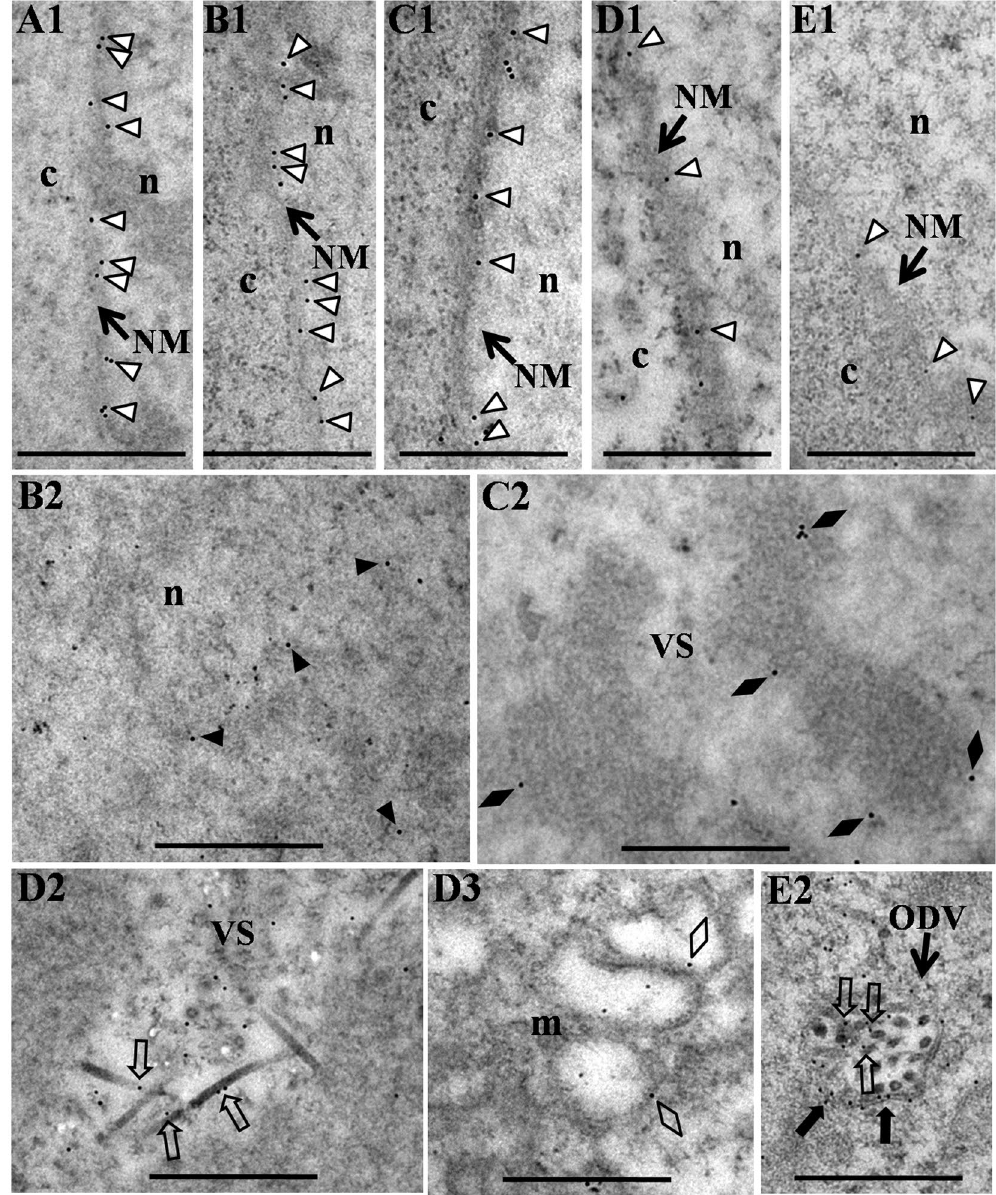
Figure 4. Immunoelectron micrographs showing the distribution of GFP-lamin B in mock- or vAc76:FLAG- infected Sf9-L cells. At the designated time points p.i., the cells were fixed, dehydrated, embedded in LR White resin, and processed for immunogold labeling with a mouse monoclonal anti-GFP antibody. ( A1 ) A mock- infected cell. ( B1–E2 ) vAc76:FLAG-infected cells at 12 h p.i. ( B1, B2 ), 24 h p.i. ( C1, C2 ), 36 h p.i. ( D1–D3 ) and 48 h p.i. ( E1, E2 ). c, cytoplasm; n, nucleus; NM, nuclear membrane; m, microvesicle; VS, virogenic stroma; ODV, occlusion-derived virion; open triangles, labeling of the nuclear lamina; black triangles, labeling of the VS; black diamonds, labeling of the edges of the electron-dense stromal mattes of the VS; open arrows, labeling of the nucleocapsids; open diamonds, labeling of intranuclear microvesicles; black arrows, labeling of the ODV envelopes. Scale bars, 500